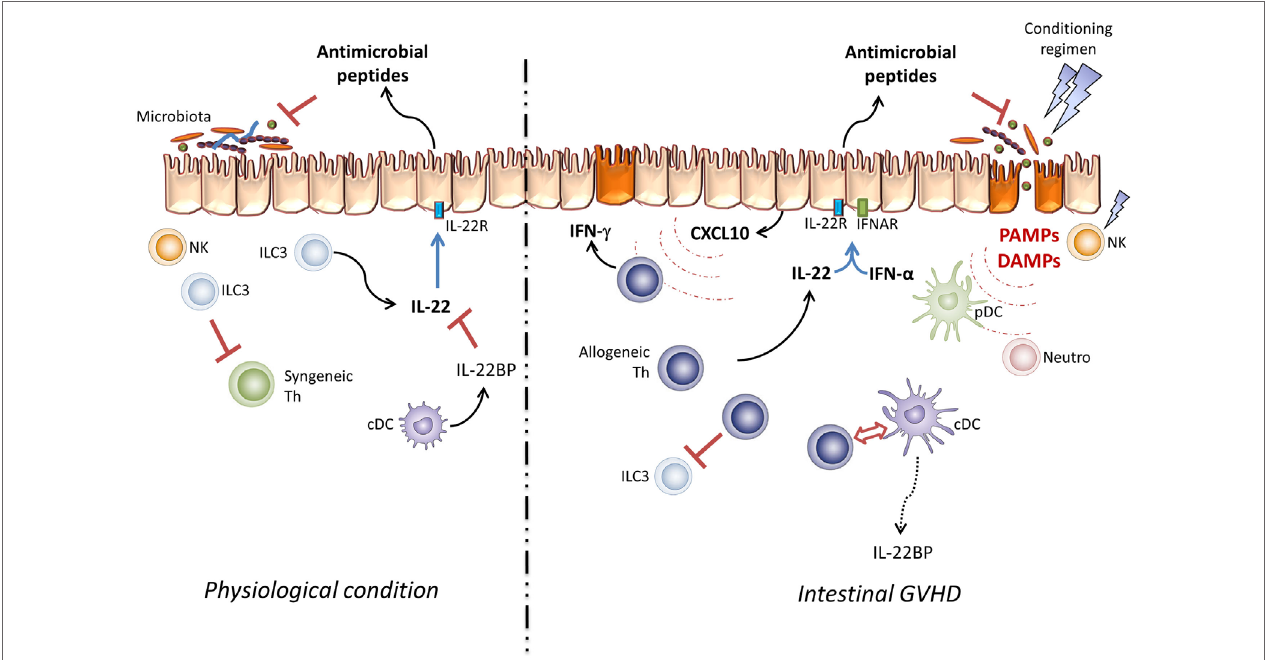
FiGURe 1 | Pathogenic effect of iL-22 in GvHD . Under physiological conditions, resident ILC3 cells take part in the intestinal microbiota and mucosal infiltrating lymphocyte homeostasis via IL-22 secretion. In this setting, IL-22 activity is controlled by IL-22BP produced by immature DC. In the allo-SCT setting, the conditioning regimen leads to epithelial barrier damage and host NK cell elimination. These lesions increase DAMP and PAMP secretion and induce pDC, neutrophil, and antigen-presenting cell infiltration, processes which activate donor T cells through the “cytokine storm.” Thus, IL-22 and type-I IFN take part in CXCL10 expression and induce Th1